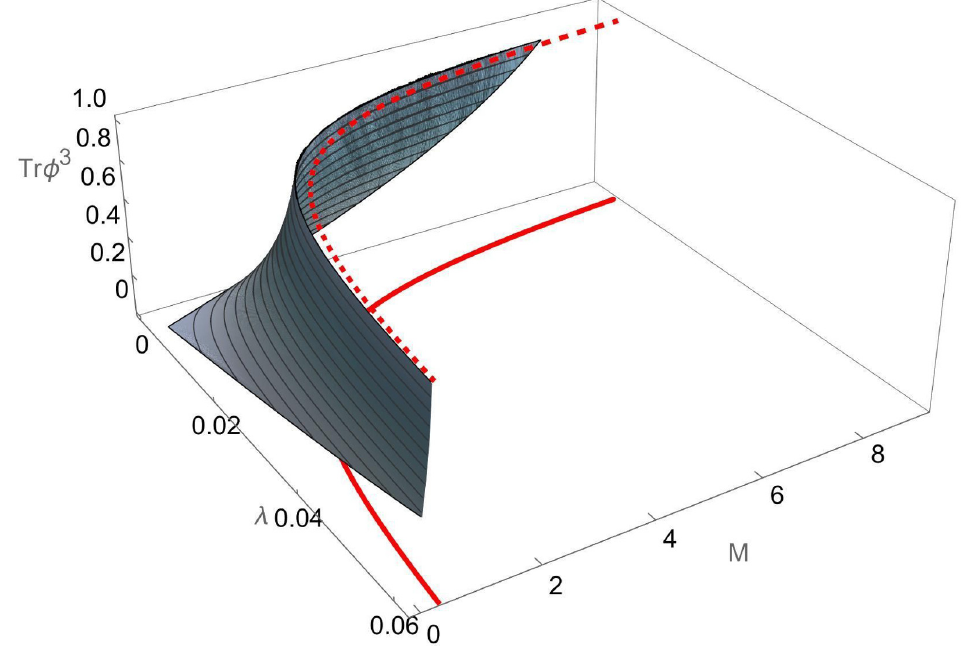
h tr φ 3 i = 1 and N